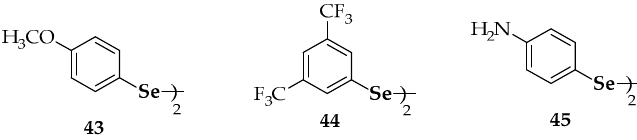
Figure 5. Synthetic diselenides with apoptotic activity [80–82].